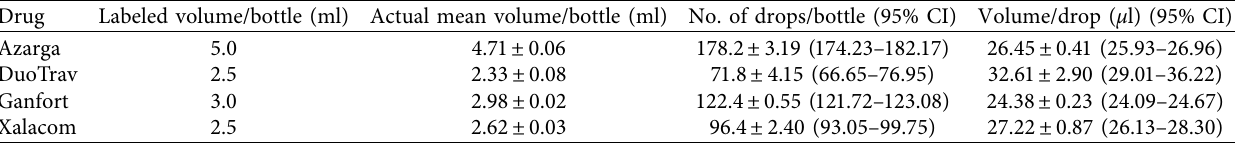
Table 1: The mean actual volume, the mean actual number of drops, the mean volume per drop, and the number of usage days per bottle of glaucoma fixed combinations.